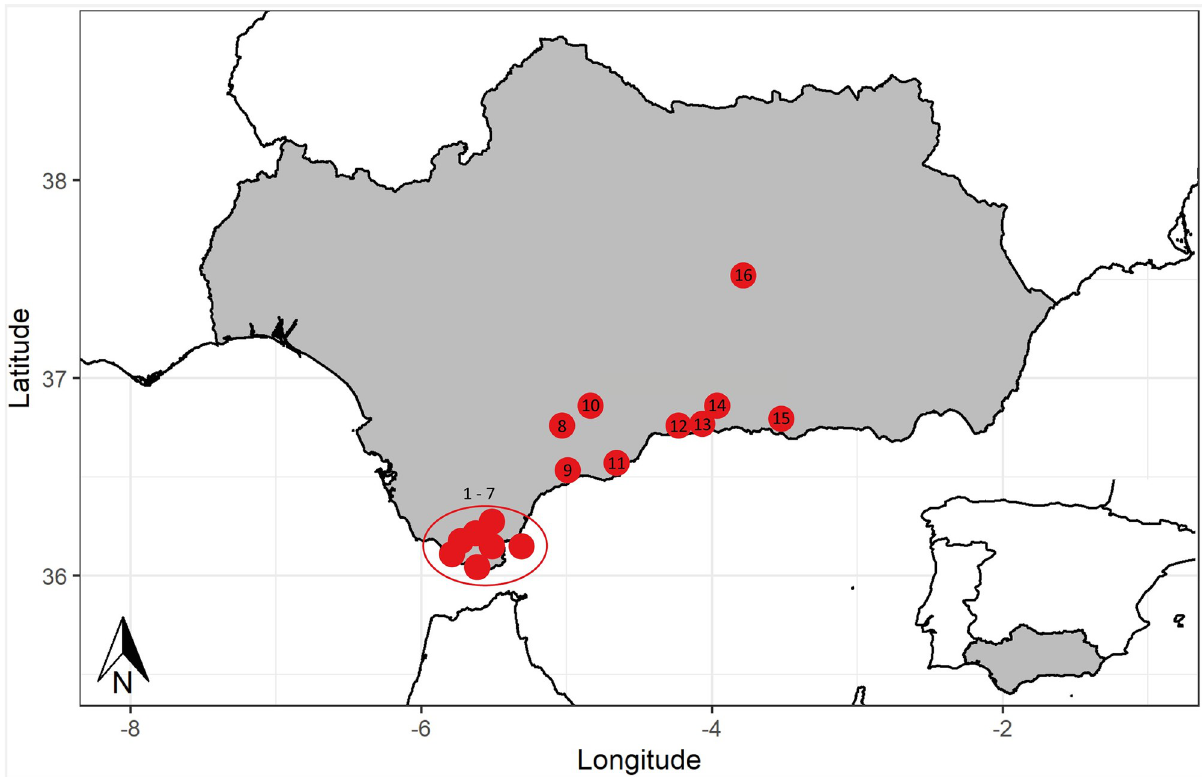
Fig 18. Distribution of rock art sites with non-figurative red paintings and handstencils in Andalusia and Gibraltar: 1: Moro, 2: Estrellas, 3: Palomas I, 4: Palomas IV, 5: Atlanterra, 6: Horadada, 7: Gorham, 8: Pileta, 9, Pecho Redondo, 10: Ardales, 11: Calamorro, 12: Navarro, 13: Victoria, 14: Higuero´n, 15: Nerja, 16: